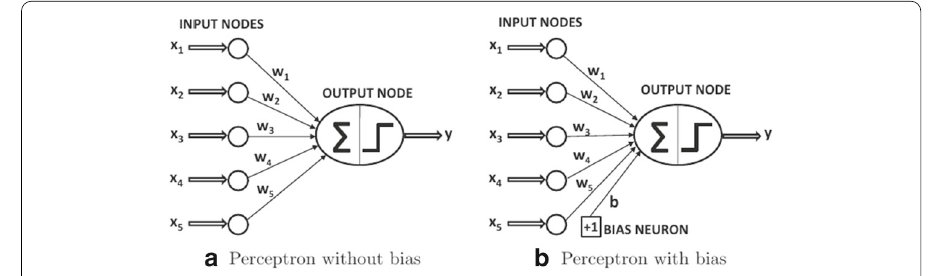
Fig. 4 Single perceptron, from [12] with/without bias and